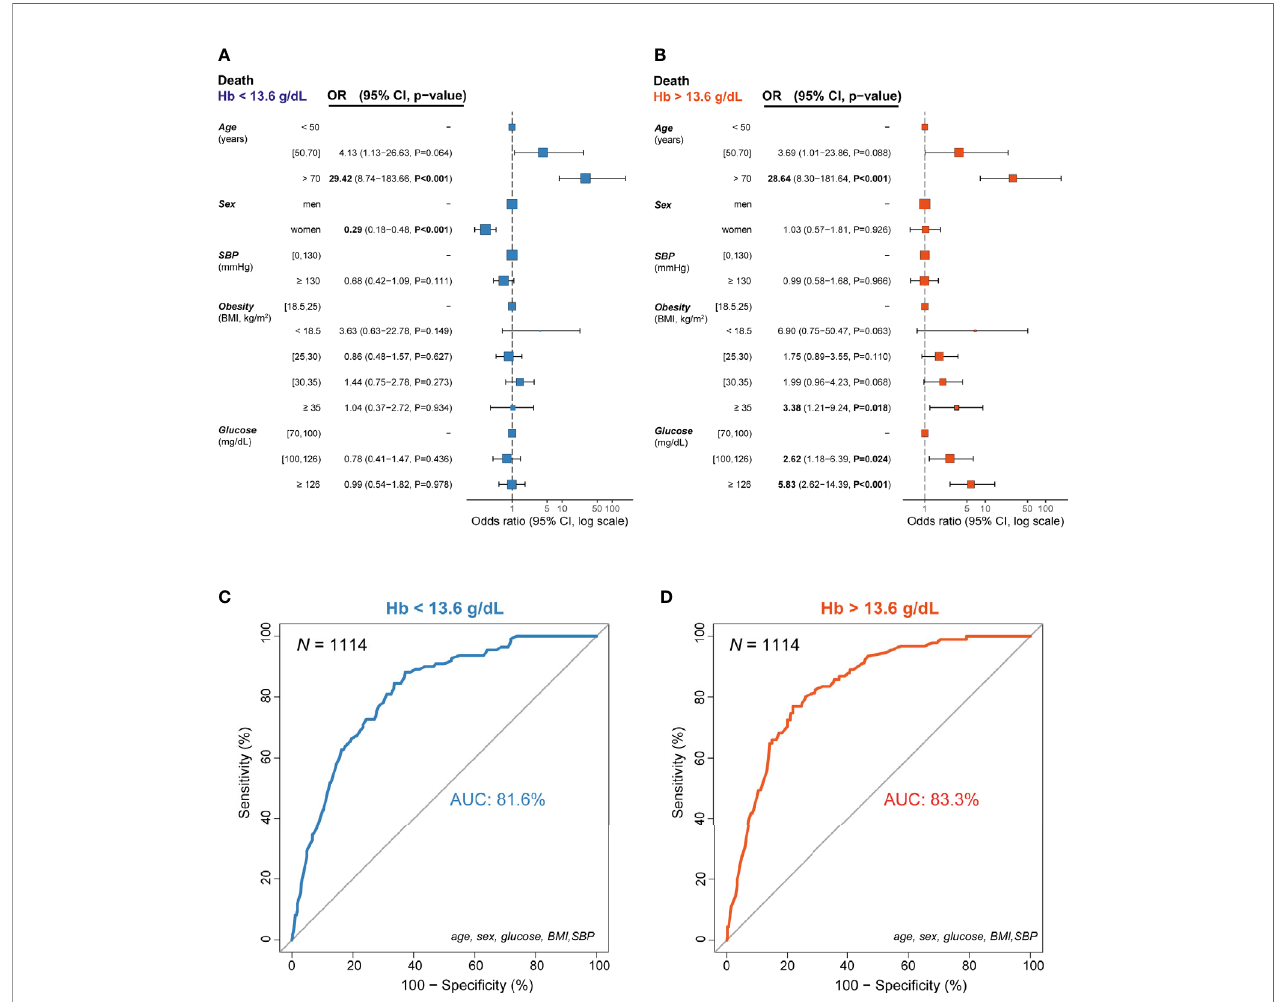
FIGURE 5 | Incidence odds ratio of mortality from COVID-19 for the fi nal models ( n =1,114) according to the median hemoglobin concentrations (13.6 g/dL). (A) In individuals with hemoglobin levels below the median, (B) In individuals with hemoglobin levels above the median, (C) Receiver operating characteristic curve for the logistic regression model in individuals with hemoglobin levels below the median, (D) Receiver operating characteristic curve for the logistic regression model in individuals with hemoglobin levels above the median. Data are presented as odds ratio (OR) and 95% con fi dence intervals (CI). The reference groups (OR=1) for each variable are shown as “ - ” .: The odds ratios shown are adjusted through a logistic regression model which includes all variables listed. Data are also represented as a forest plot. AUC, area under the curve.